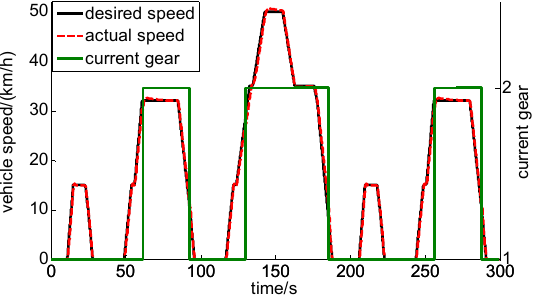
Figure 8. Curves of gear number and angular velocity in the new European driving cycle (NEDC) driving cycle.